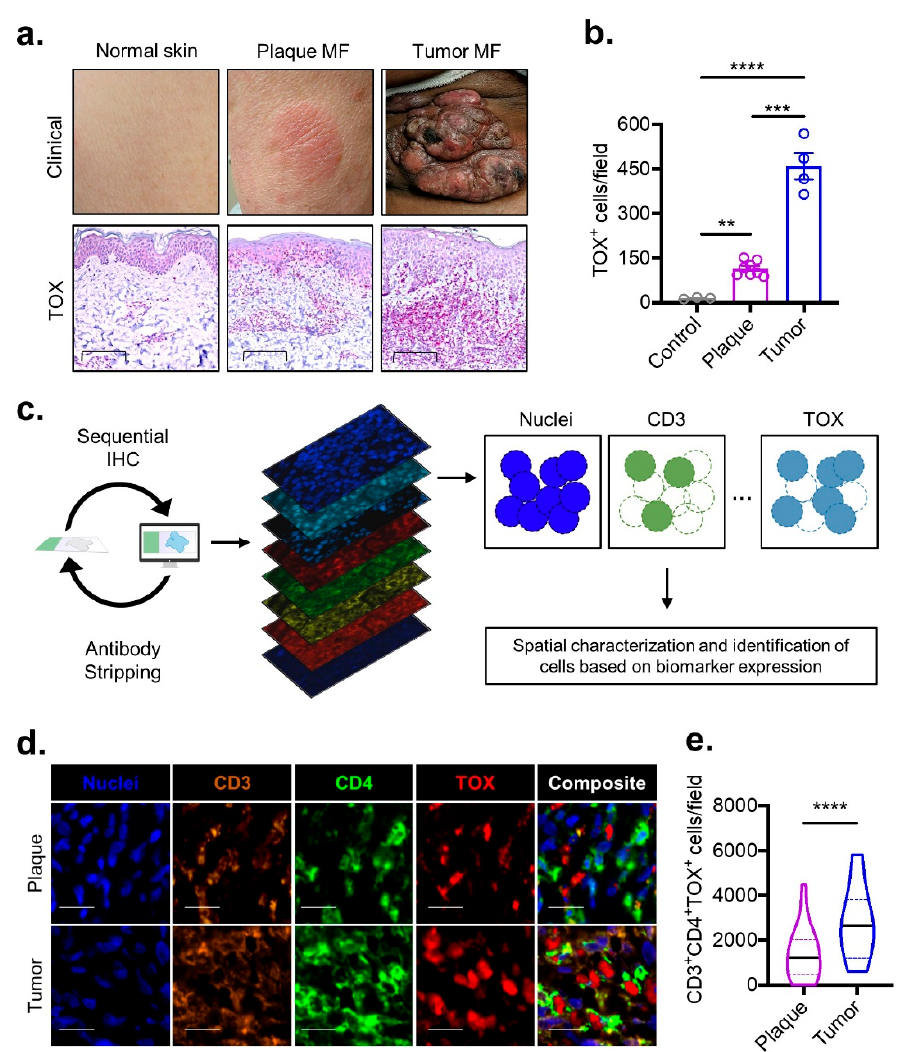
Figure 1. TOX density correlates with MF disease stage. ( a ) Representative clinical images (top) and high-powered immunohistochemical TOX staining (bottom, scale bar 100 μ m) for non-neoplastic normal skin compared to plaque and tumor stage MF. ( b ) Composite data illustrating the number of TOX-positive cells per field for the groups described in subfigure ( a ) ( n = 3 control, n = 7 plaques, n = 4 tumors). ( c ) Experimental schematic demonstrating the pipeline for employing multispectral imaging to quantify cells of a specific phenotype. Samples undergo sequential immunohistochemical staining for a panel of several biomarkers followed by computer vision-based analysis to locate and identify cell types. ( d ) Multispectral imaging (scale bar 20 μ m) from plaque and tumor stage MF stained with the indicated biomarkers. ( e ) Violin plots of composite data enumerating density of CD3 + CD4 + TOX + cells per multispectral field for pooled plaque ( n = 5) or tumor ( n = 2) MF samples. Bar plots represent mean ± SEM. Violin plots represent the median with the 25th and 75th percentiles. **, p < 0.01; ***, p < 0.001; ****, p < 0.0001 by one-way ANOVA with Sidak–Holm’s correction (panel b ) or unpaired t -test with Welch’s correction (panel e ).